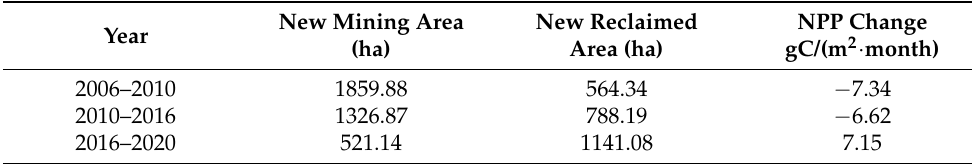
Table 4. Changes in new mining area, new reclaimed area and NPP in the mining area from 2006 to